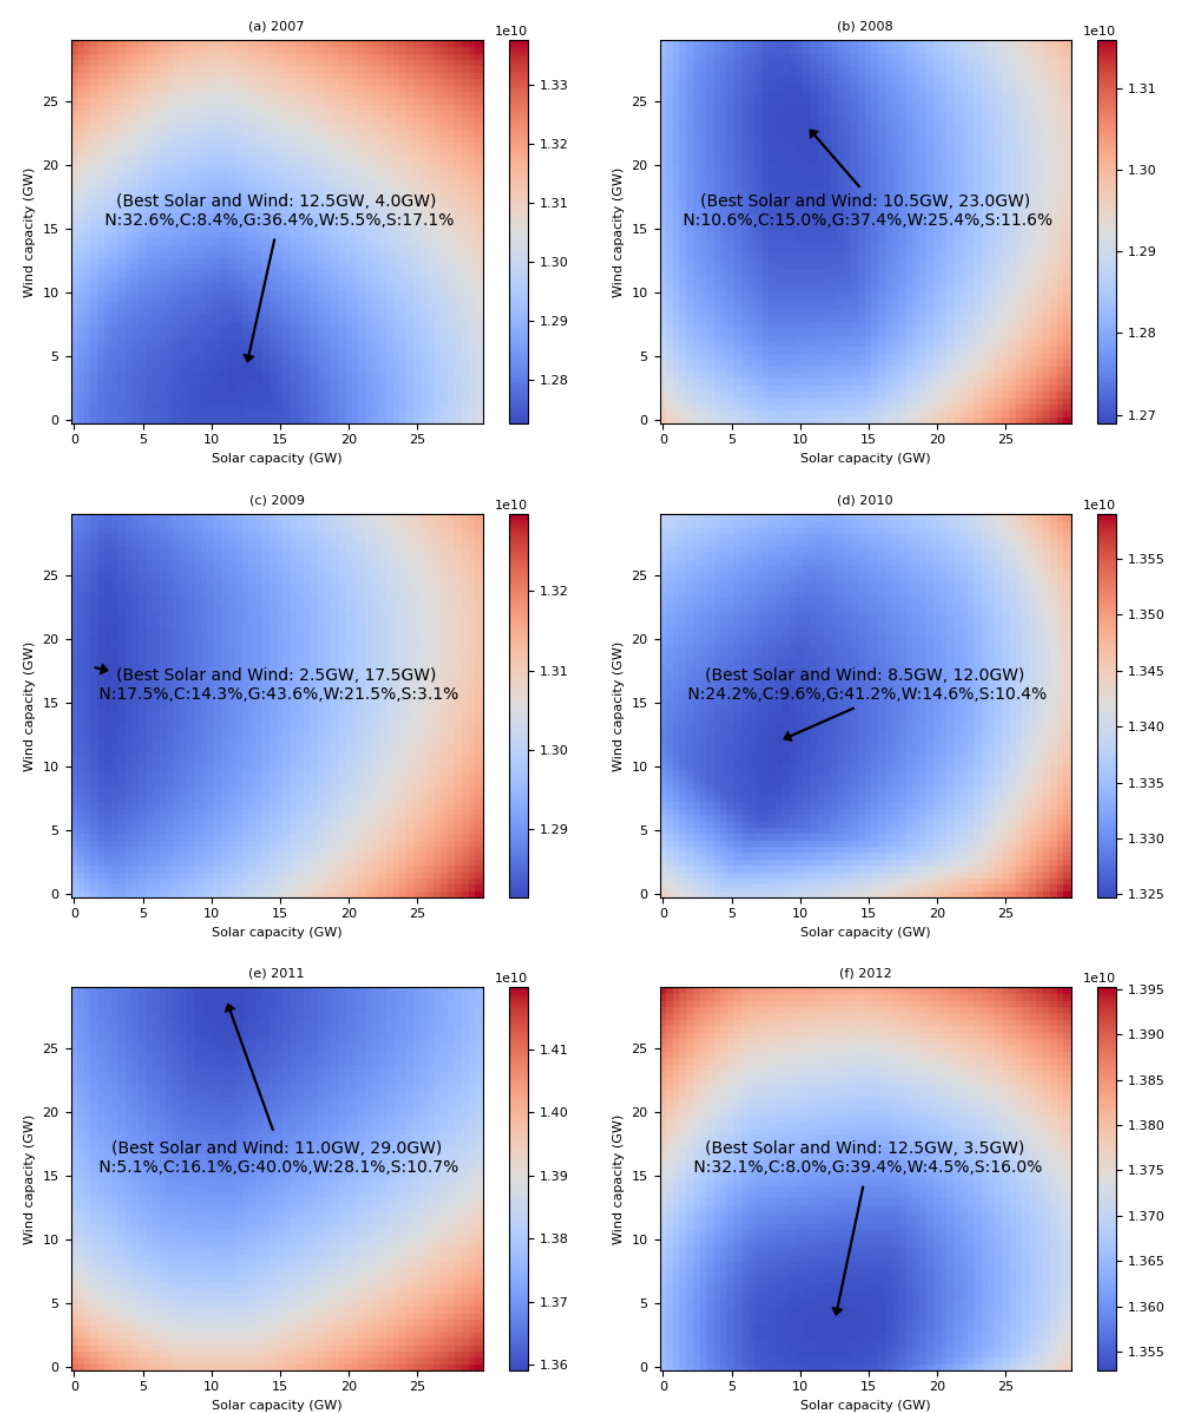
Figure 12. Heat map of cost estimate for ( a ) 2007 ( b ) 2008 ( c ) 2009 ( d ) 2010 ( e ) 2011 ( f )